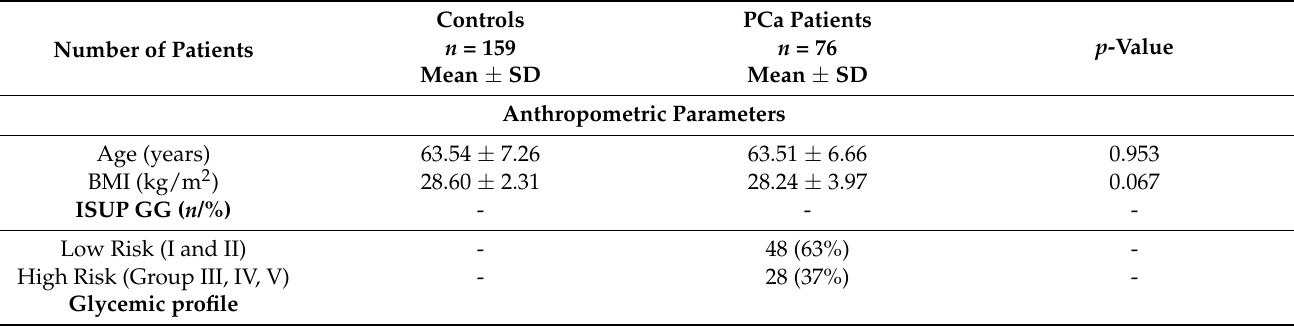
Table 1. Anthropometric and analytical characteristics of the studied